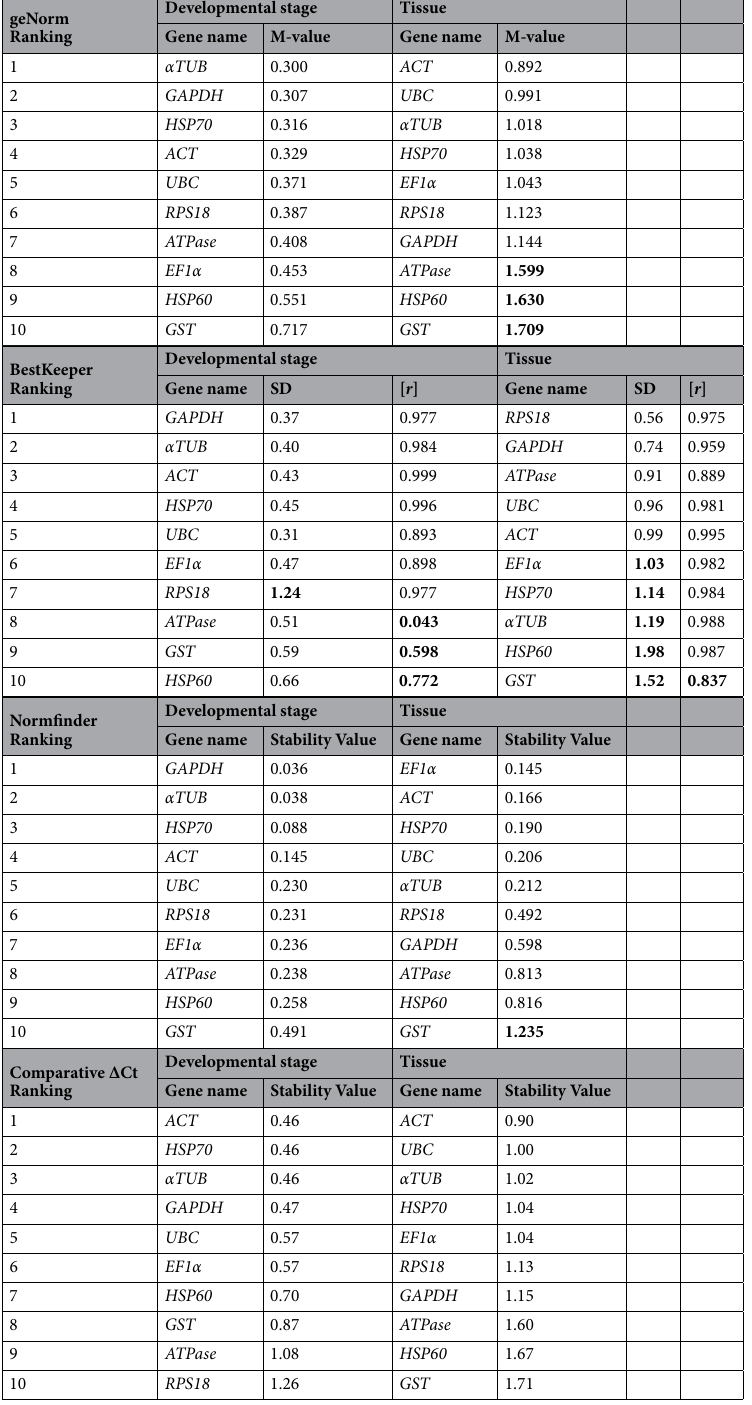
Table 1. Ranking of candidate reference genes. The bold indicates the gene expression is unstable under specific experimental